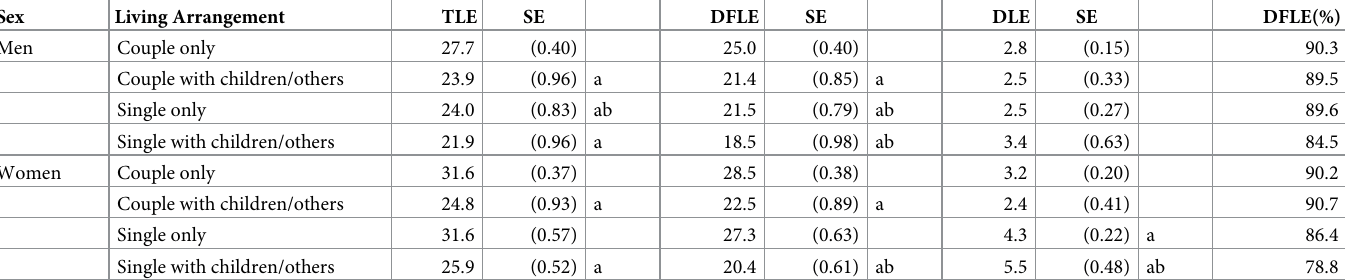
Table 7. Total, disability-free, and disabled life expectancy by gender and living arrangement for non-Hispanic whites at age 50 among those who never change their living arrangement during analysis period: Population-based estimates. Sex